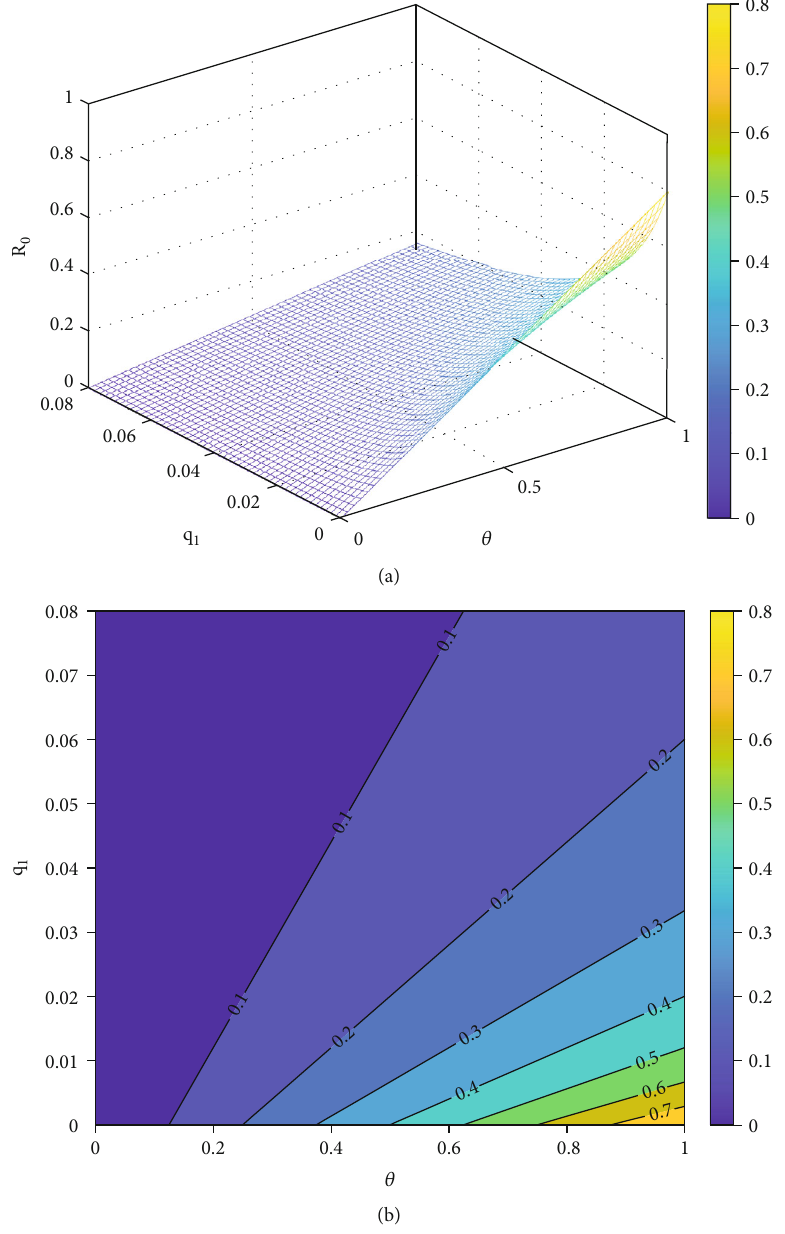
R θ and q 0 vs. 1 ,